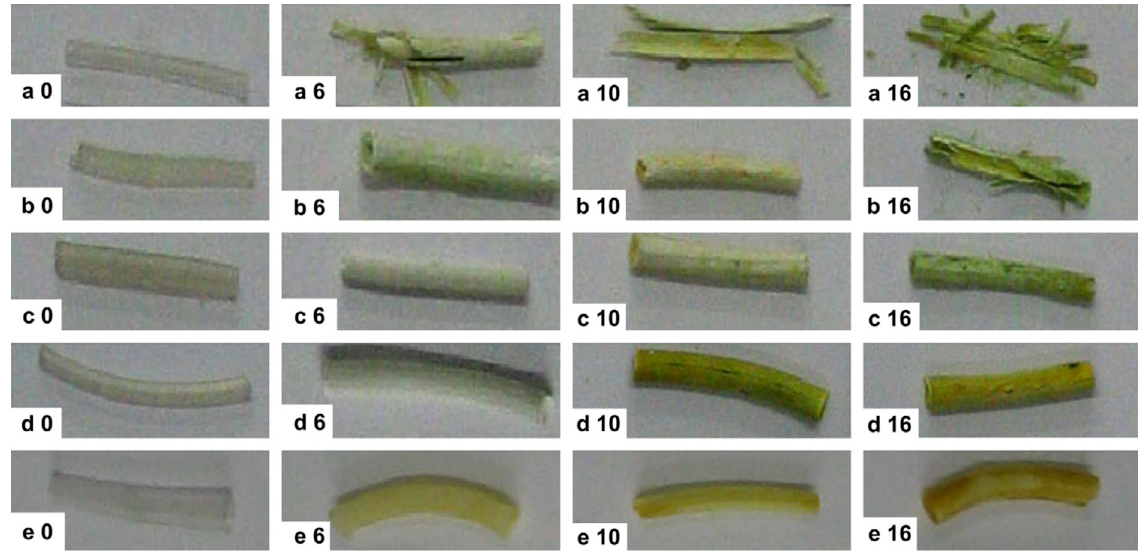
Figure 10. Optical images of PLGA stents in different degradation stages (days) in bile at 37 °C in vitro. Lactic acid/glycolic acid (LA/GA) ( a ) of 50/50; ( b ) 60/40; ( c ) 71/29; ( d ) 80/20; and ( e ) 88/12, reproduced from [144] with permission from Elsevier, 2019.